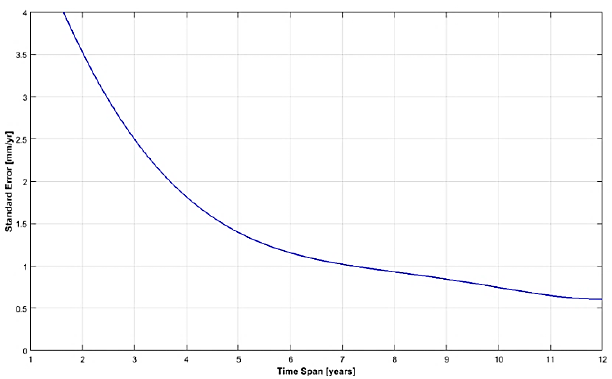
18 of 31 Figure 13. Upper image: The GVD8 altitude (height) daily solutions over 2014 using the IGS (“old”) and the Geo++ (“new and calibrated”) antenna parameters. Lower Image: Residuals between the two solutions in the altitude (height) determination for the GVD8 Cal/Val site. Also, different types of GNSS geodetic antennas are implemented when tracking satellite signals. These could be choke ring with ground plane, with radome, software multipath reduction, etc. Preference is given to special multipath-limiting antennas (i.e., choke ring or multi-beam).